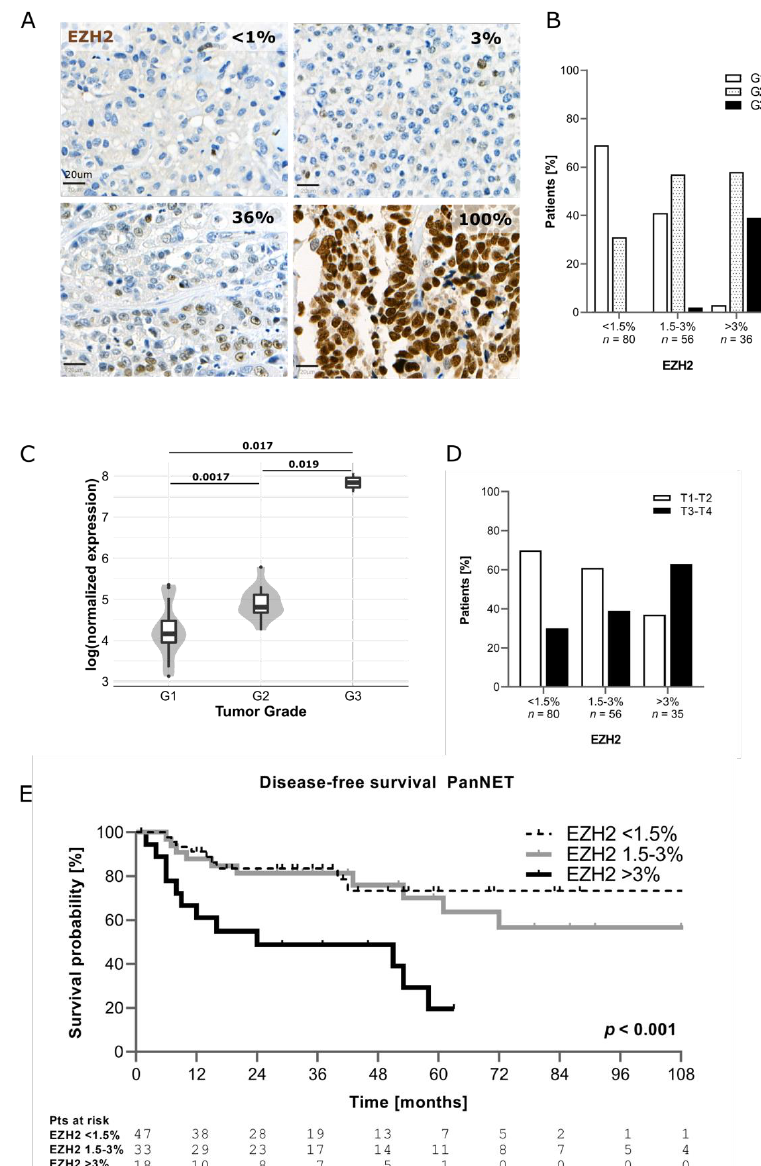
Figure 1. ( A ) Example of EZH2 expression in human tissue. ( B ) Correlation between EZH2 expression and tumor grade. ( C ) Correlation between EZH2 mRNA level and grade (data from Scarpa et al. 2017). ( D ) Correlation between EZH2 and T stage (T stage missing (n = 1)). ( E ) Comparison of disease-free survival between patients with low, intermediate, and high EZH2 expression (only PanNETs were included) .